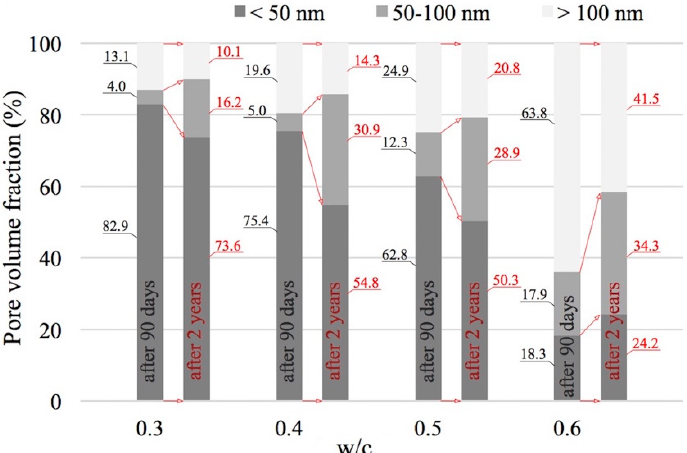
Figure 6. Proportions of different pore classes in pastes with different w/c ratios after 90 days and 2 years of curing.